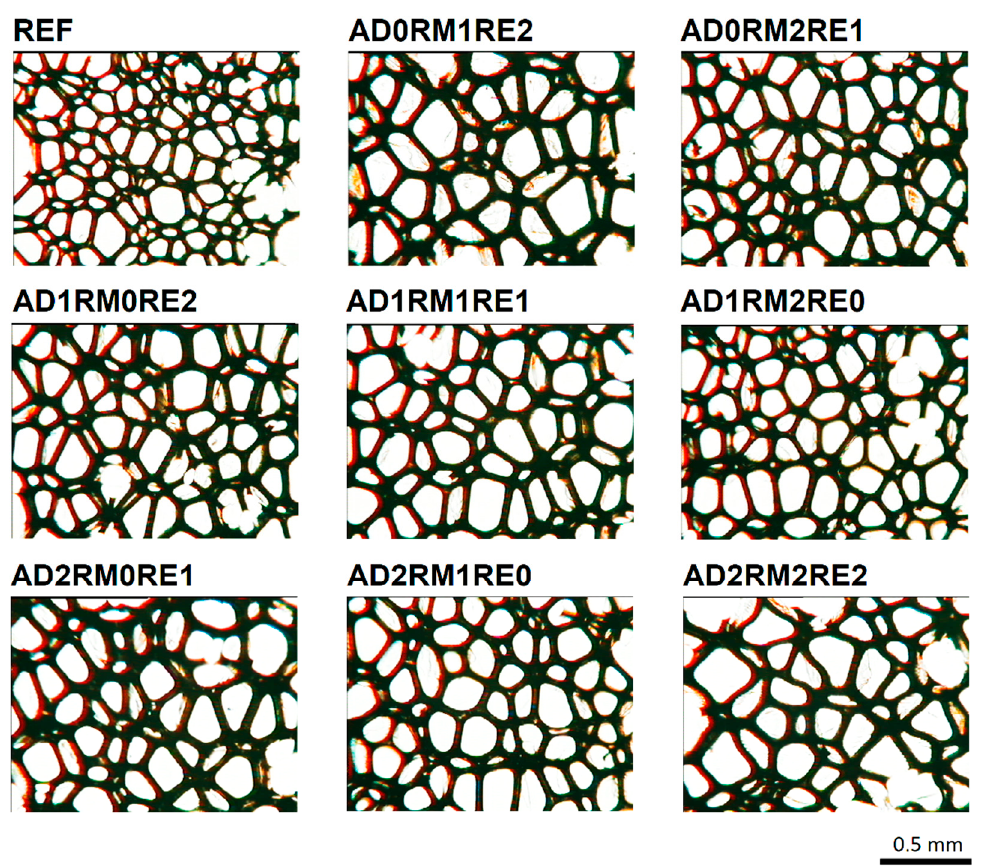
Figure 3. Microphotographs of the foam cell structure in the cross-section parallel to the foam rise direction.